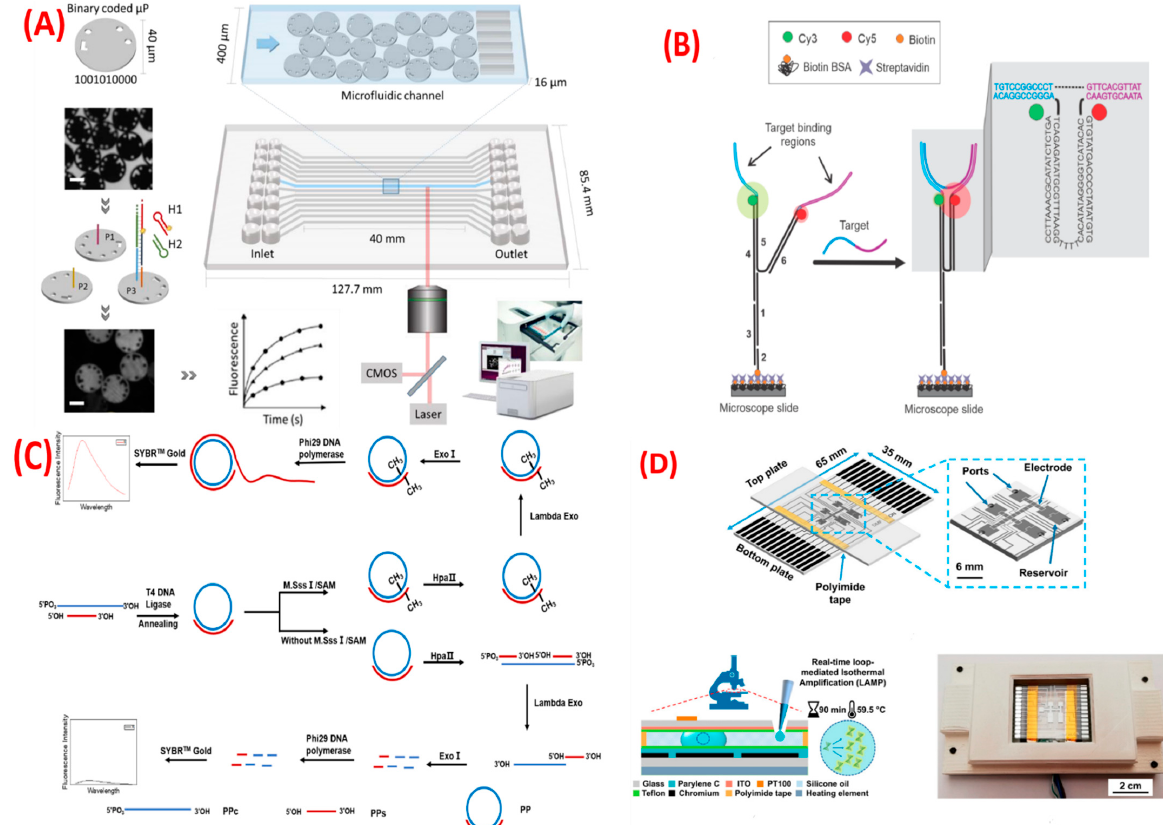
Figure 4. ( A ) Schematic representation of the components, including digitally barcoded nanoparti- cles, microfluidic cartridge, and an integrated instrument for the detection of molecular biomarkers [112] ( B ) Working principle of the nucleic acid-based nanotweezer sensor [113] ( C ) MTase activity uncovering by padlock probe with RCA technique [114] ( D ) Multi-view of the DMF device and accumulation